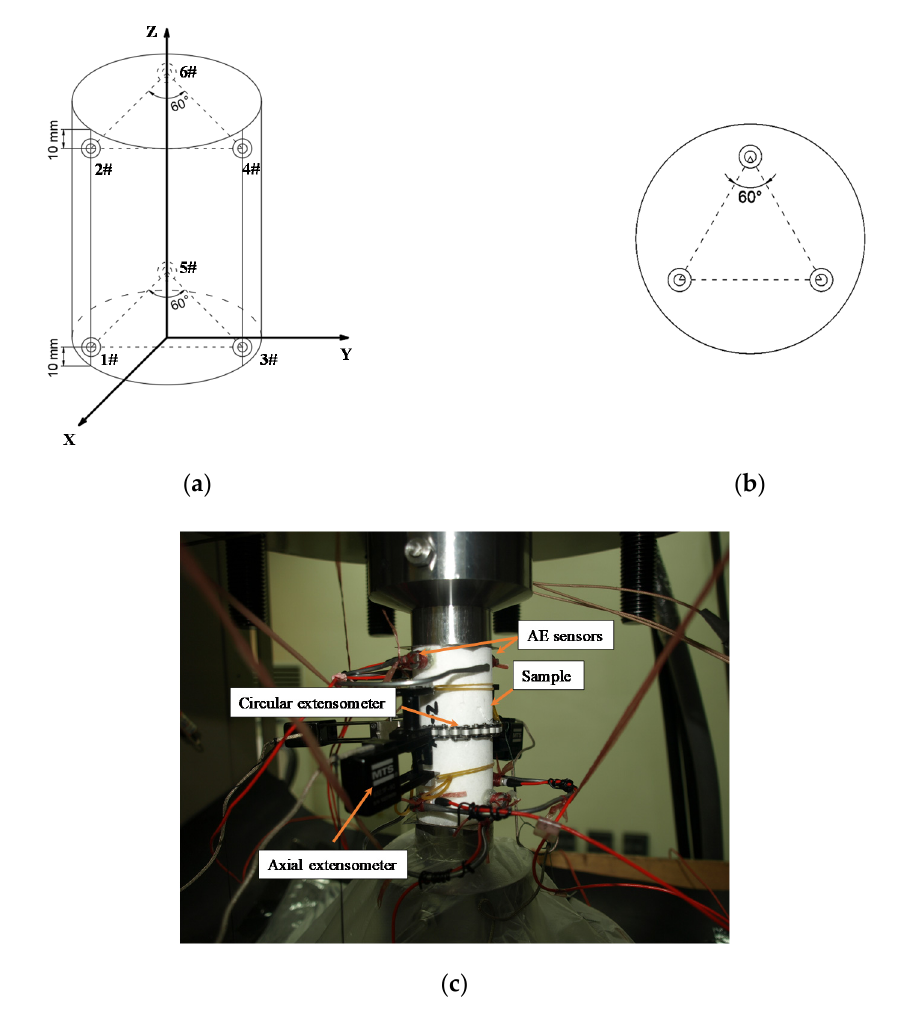
Figure 2. Acoustic emission (AE) sensors setup for tests under different loading methods: ( a ) AE sensors placement in the DTT, ( b ) AE sensors locations in the ITT, ( c ) Overall arrangement of the experiment (a UCT is shown as an example).